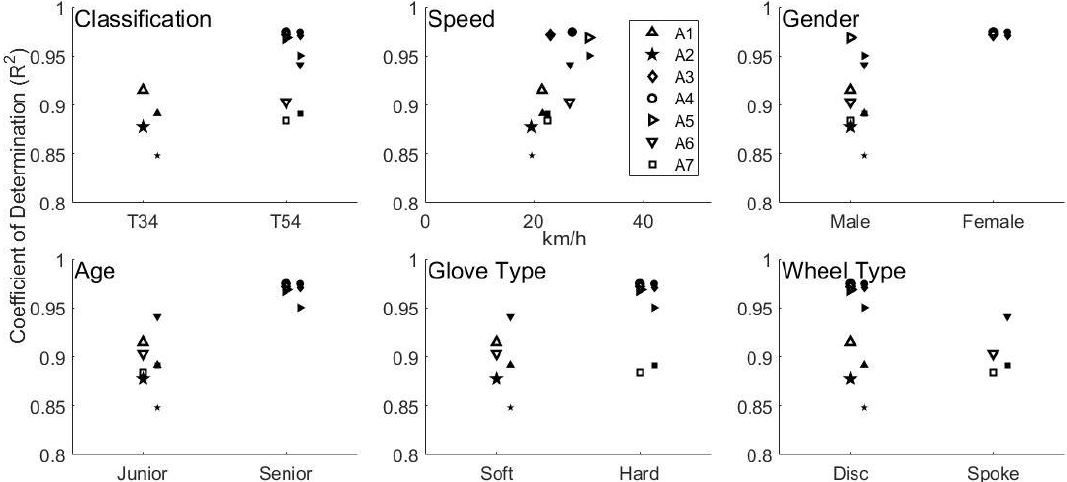
Figure 3. Capability assessment of the accuracy of the IMU based contact detection methodology across varying athlete characteristics as presented in Table 1. Coefficient of determination ( R 2 ) data are presented from the FL (open markers) and FR (solid markers) for each